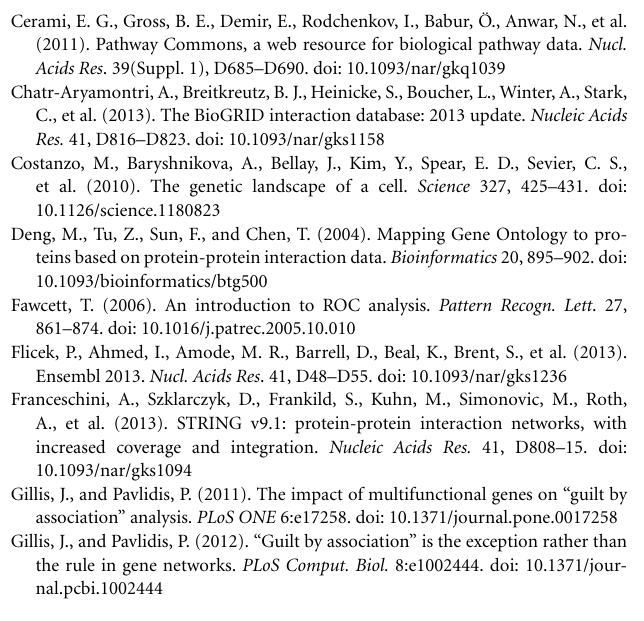
Network Assessor is open-source and is part of the GM